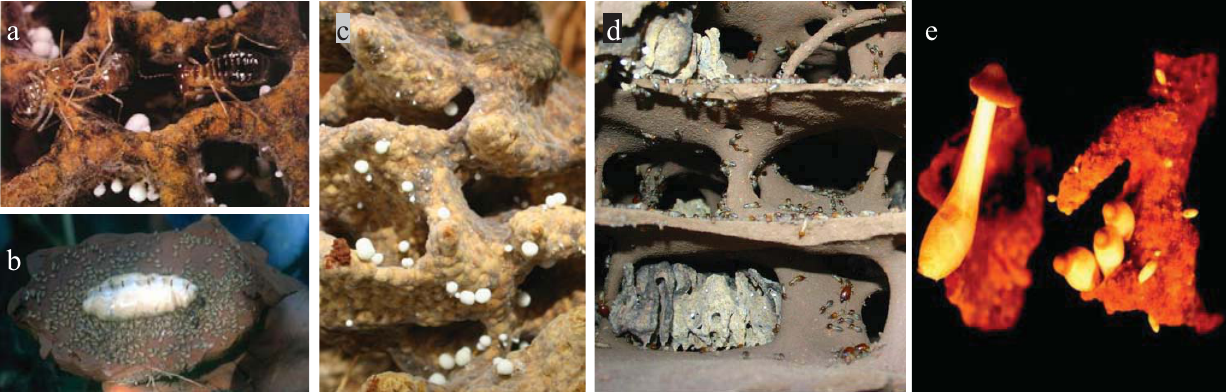
Figure 1. Aspects of the mutualism between fungus-growing termites and Termitomyces fungi, using Macrotermes as a model system. ( a ) Close-up of a fungus garden with multiple asexual fruiting bodies (nodules). The spores survive passage through the termite gut and are mixed with predigested plant material to be deposited as inoculated fresh garden substrate [17,18]; ( b ) the queen and king in an opened royal chamber; ( c ) A fungus garden showing freshly-deposited substrate on top (dark), multiple nodules in mature parts (white structures), and degraded lower parts; ( d ) the inside of a colony showing the interconnected network of chambers that contain fungus gardens, containing a mass of masticated plant substrate in which Termitomyces grows (the fungus comb); ( e ) Mushrooms of various developmental stages of a colony Macrotermes natalensis ; ( f ) Key aspects of the life cycle of a typical species of fungus-growing termites with horizontal transmission [23]. The fungus is clonally propagated via asexual spores inside the colony [24], which can live for more than 20 years. Dispersal occurs via the yearly production of sexual offspring, independently in termites (alates) and fungi (sexual spores from mushrooms); ( g ) Patterns of coevolution between fungus-growing termites (left) and their associated Termitomyces fungi (right)